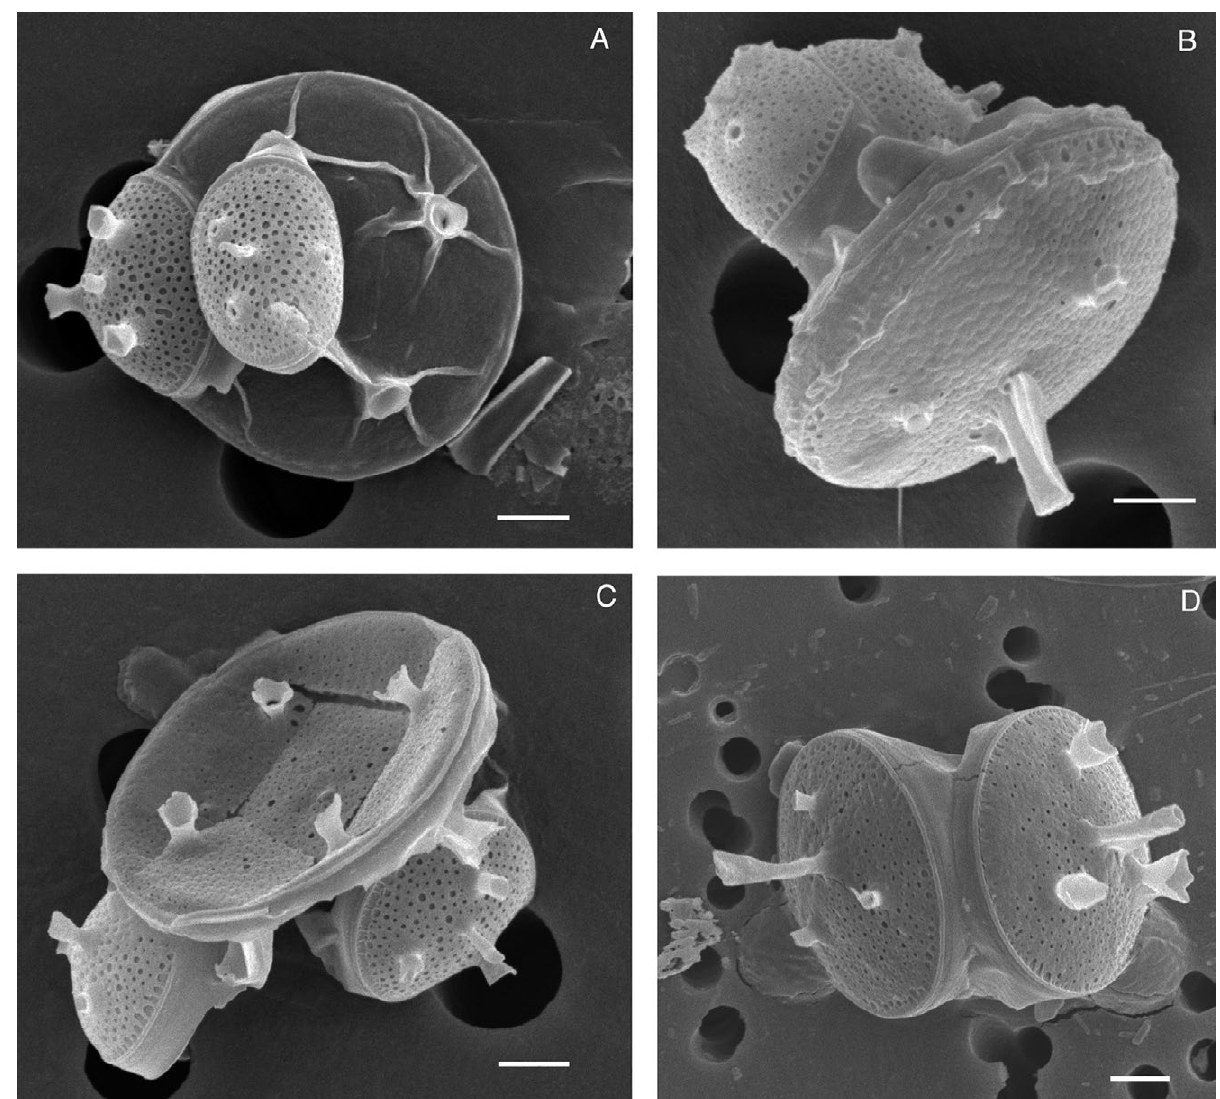
Fig. 2. – Size regenerated initial cells of Minidiscus comicus on 11 May 2009 with the valves of a parent cell still attached. A-C, 11 May 2009; D, 19 September 2009. Scale bar 1